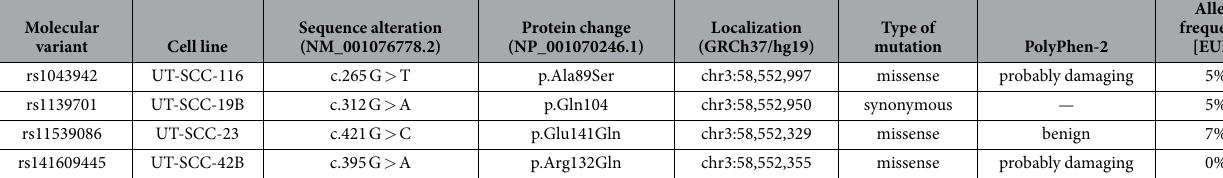
Table 1. The molecular variants detected in cell lines and their potential effect on the FAM107A gene (1000 Genomes database).